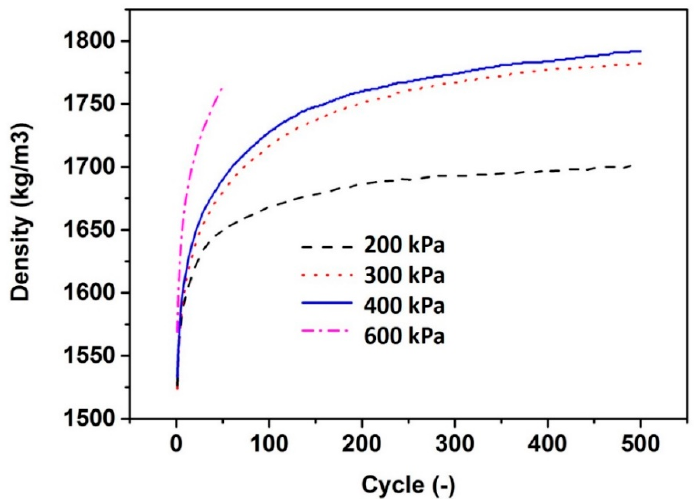
Figure 2. Bulk density of coarse gravels as a function of shearing cycle of the Gyratory Compactor at different shear strength.